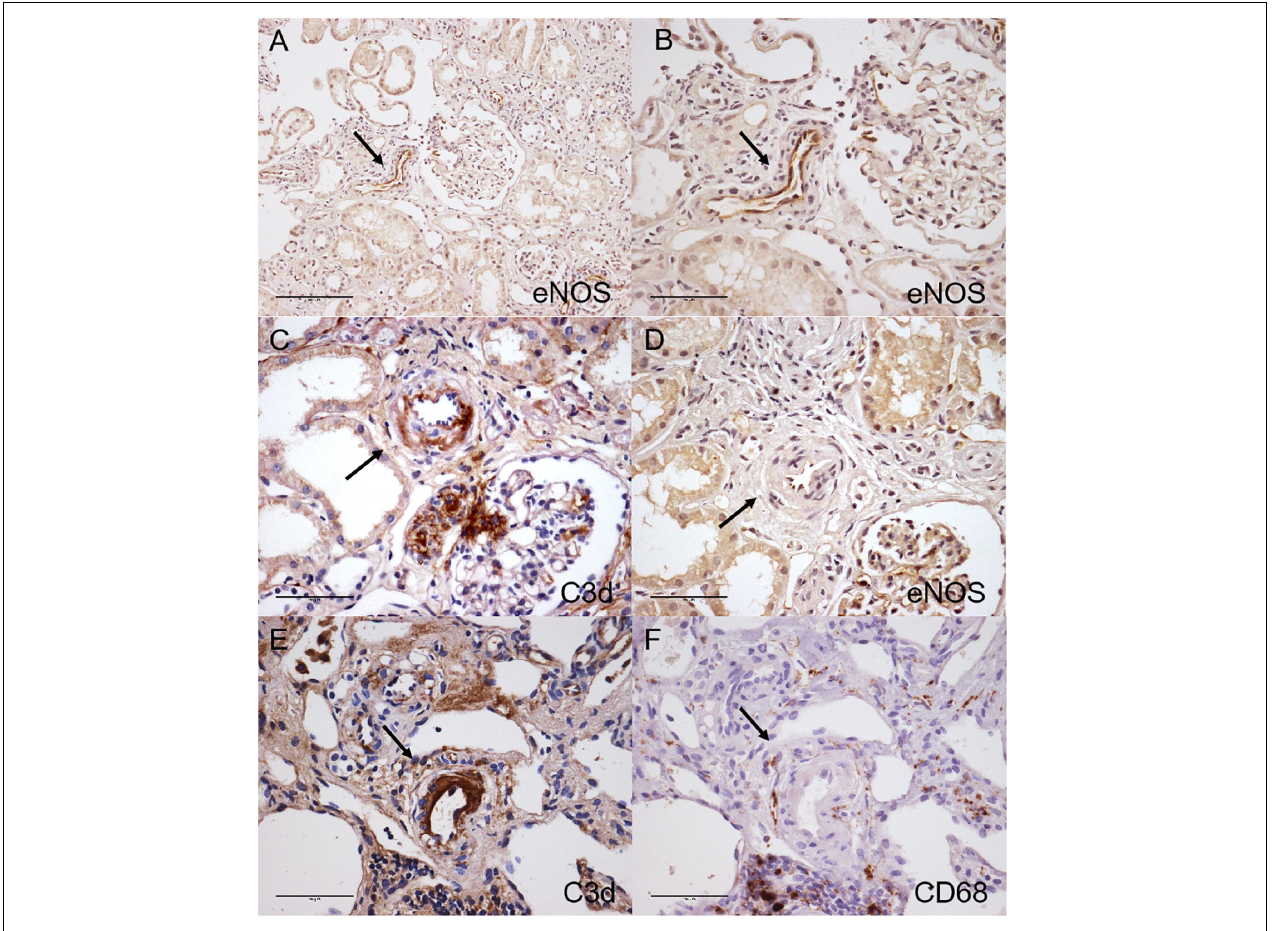
FIGURE 7 | Immunohistochemical staining for C3d (C,E) , eNOS (A,B,D) and CD68 (F) in arterionephrosclerosis. Uninvolved arterioles showed positive eNOS staining along the endothelial layers ( A , 200 × ; B , 400 × ). The C3d-positive arteriole with arteriosclerosis showed decreased eNOS staining ( C,D , black arrow, 400 × ). (E,F) Shows macrophages surrounding C3d-positive staining arterioles (black arrow, 400 ×